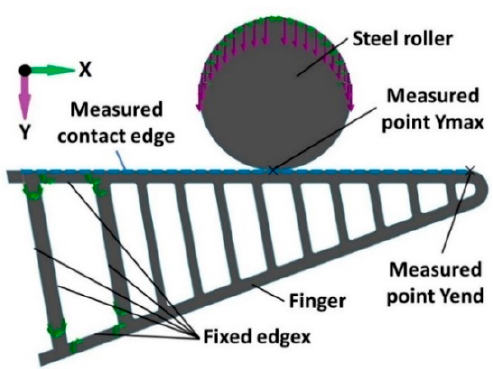
Figure 4. Simulated assembly.